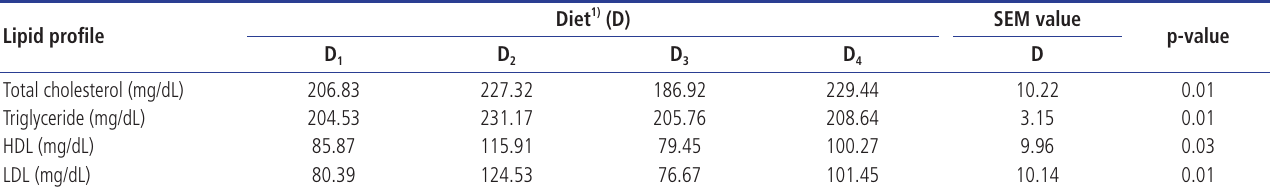
Table 3. Effect of multivitamin or acidifier on lipid profiles of blood of broiler chickens at 35 days of age Lipid profile